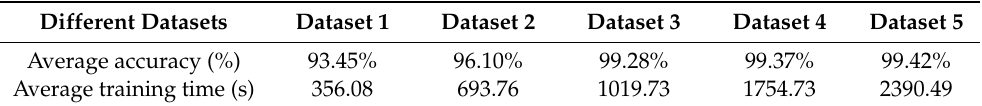
Table 4. Diagnostic performance of the proposed method under different data sets.